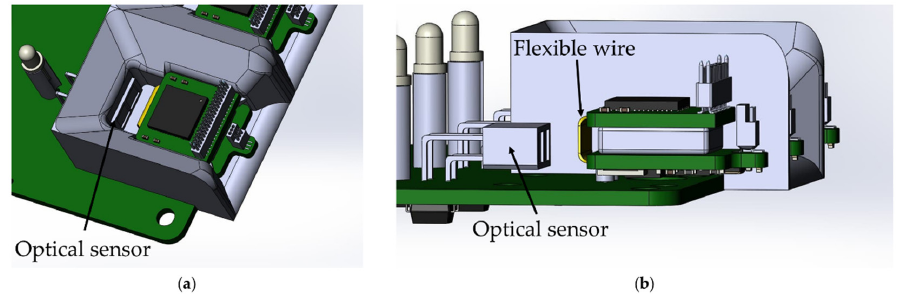
Figure 9. Location of the optical sensor ITR-9909 on the base station board: ( a ) top view, ( b ) side view without showing the wireless module mount.